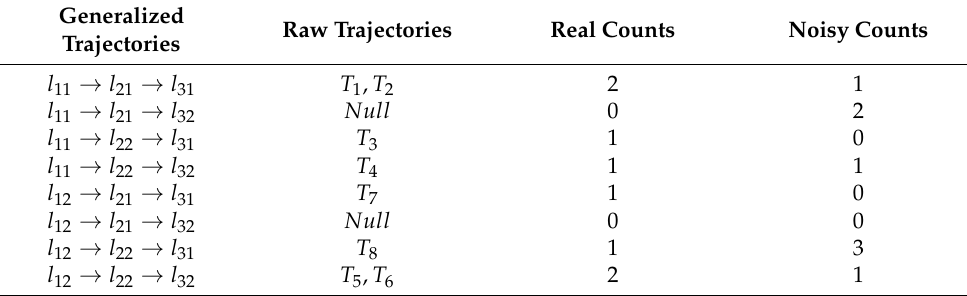
( a ) An example dataset with 8 trajectories. ( b ) Location Generalization. Figure 3. An illustration of the trajectory reconstruction algorithm. Table 2. Differentially private publication of the sample data in Figure